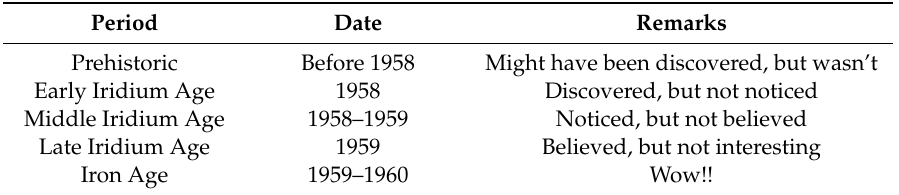
Table 2. “Historical phases” of the Mössbauer effect. Reproduced from [25].